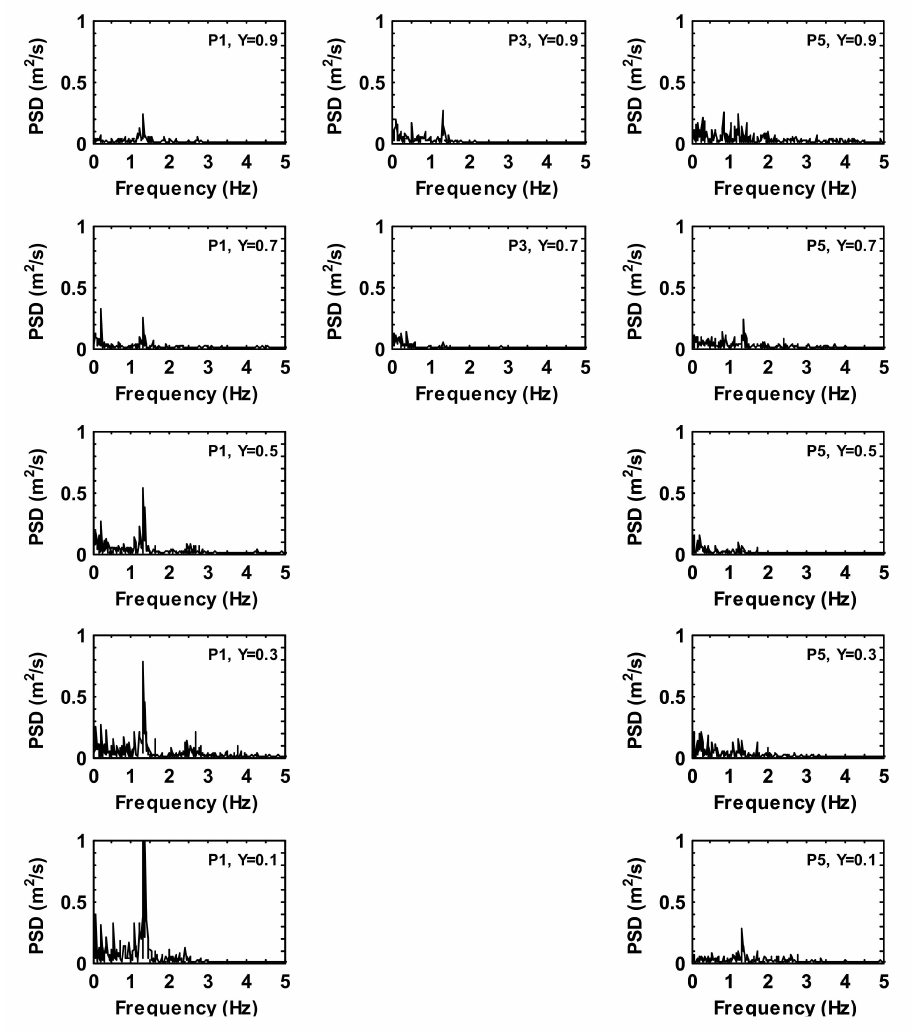
Figure 12. Power spectra density of the time history velocity magnitude fluctuations at monitoring locations P 1, P 3, P 5 for case